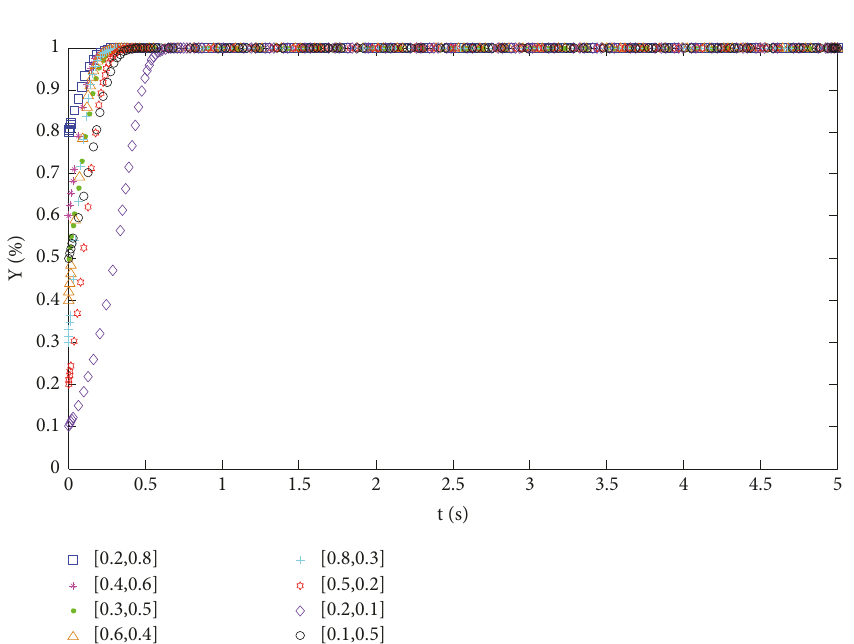
Figure 2: The X-t type of phase diagram (ESS: D(1,1)).